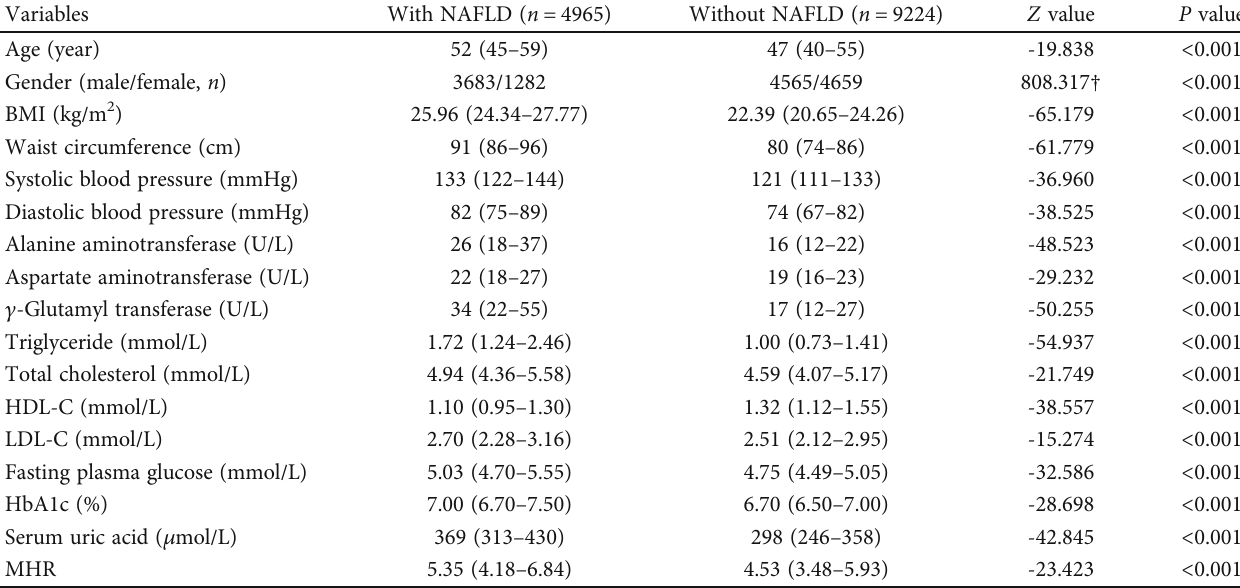
Table 1: Comparison of clinical characteristics between the subjects with and without NAFLD.